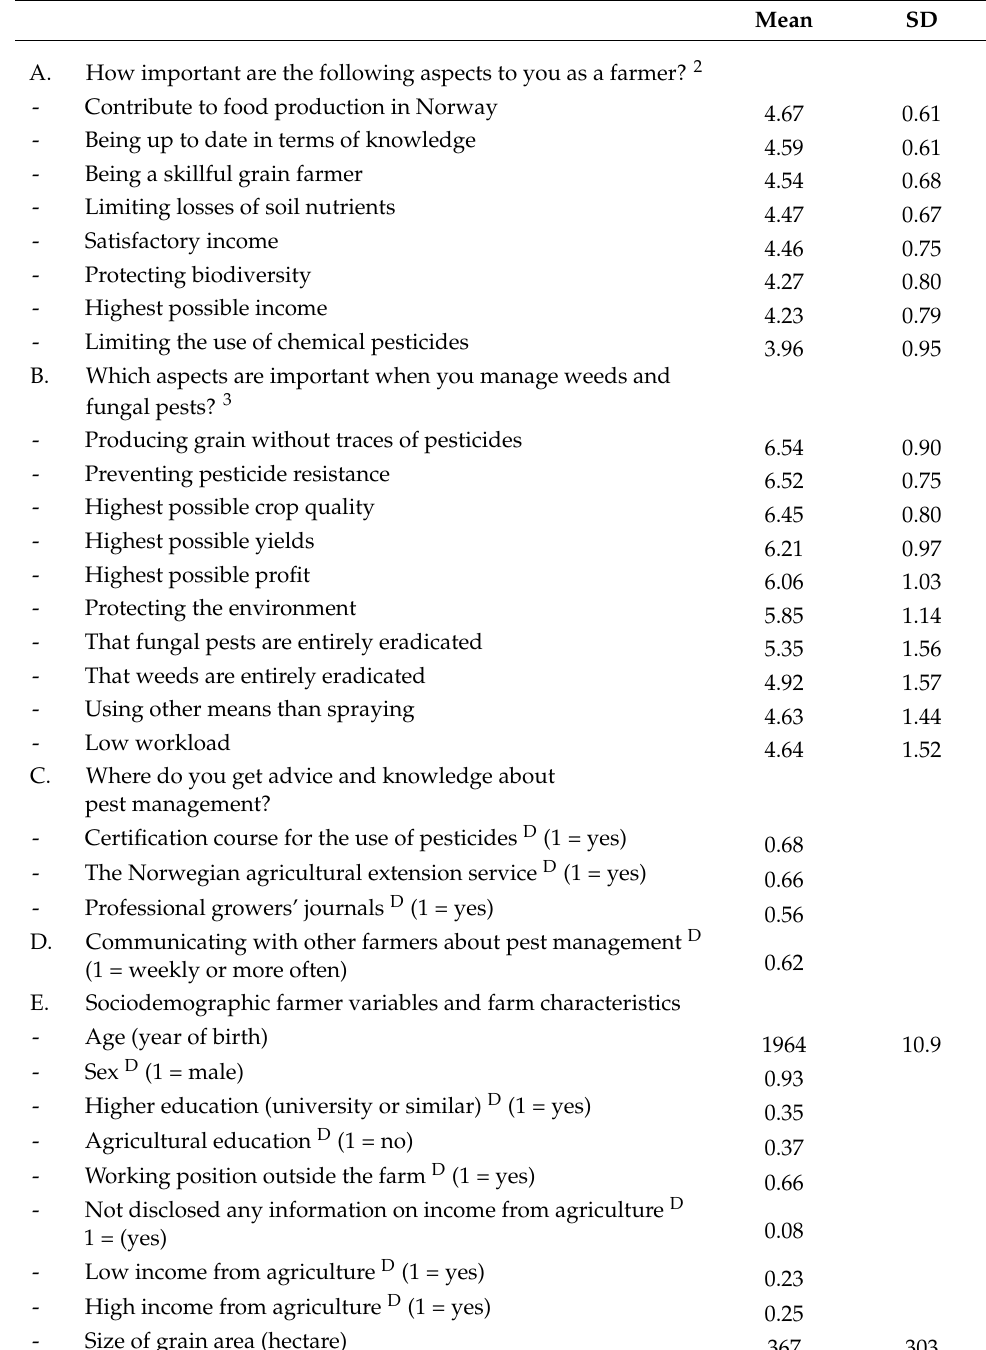
Table 5. Independent variables as based on questions from the Post-survey (N = 616 1